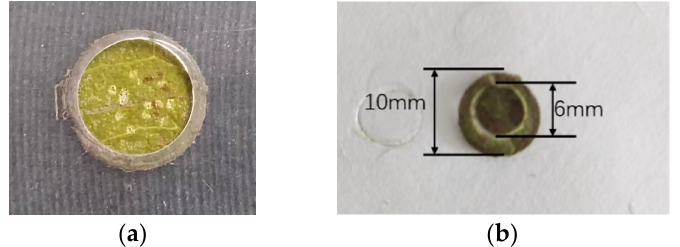
Figure 2. Schematic of sample processing: ( a ) sample after detected by LIBS and ( b ) cut into two parts.